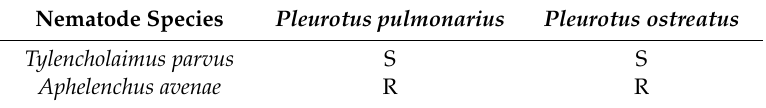
Table 2. Nematode interactions with two species of Pleurotus grown on water agar from Okada et al. (2005b) [14]. One nematode species was susceptible to both Pleurotus species, while the other nematode species was resistant to both Pleurotus species. However, di ff erential interactions (i.e., resistance to one Pleurotus species but susceptibility to the other), were not observed. S = susceptible, R =